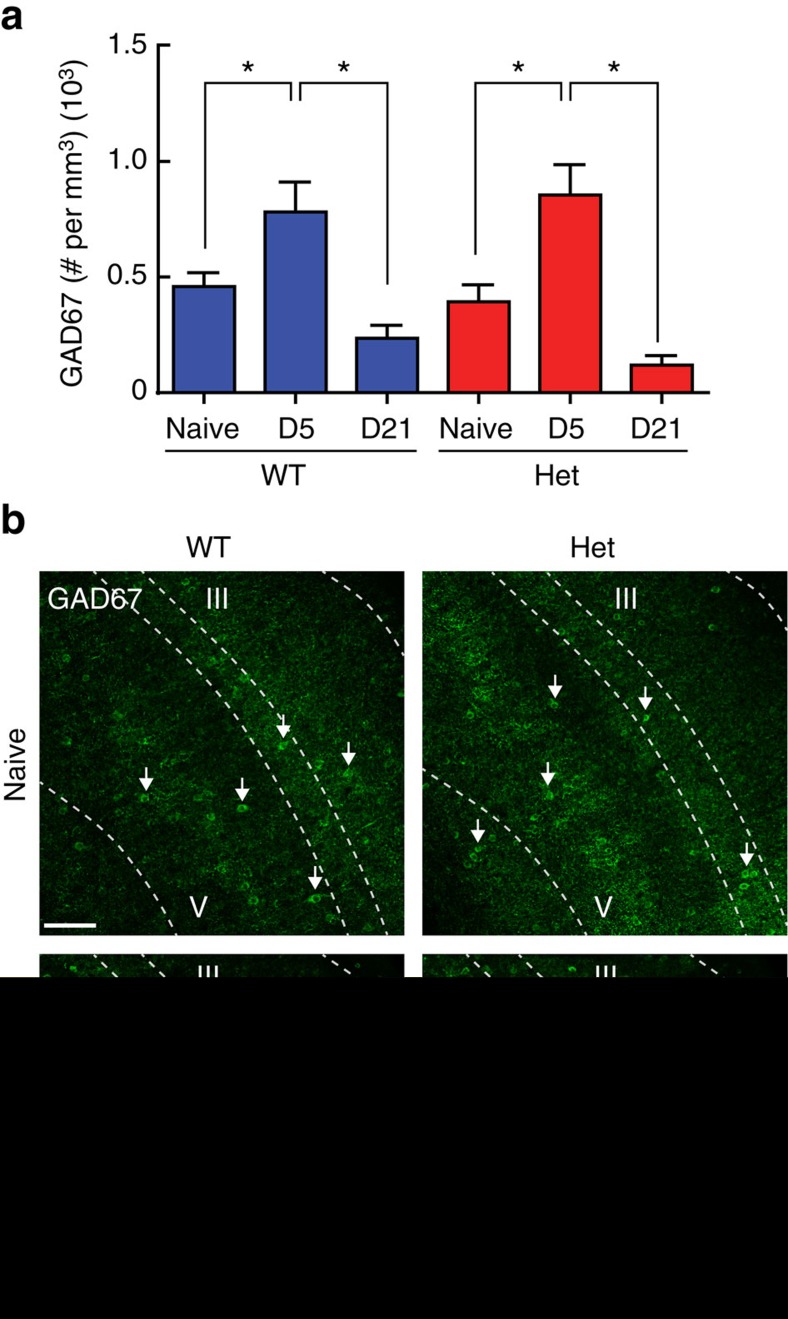
Maternal experience transiently enhances GAD67 expression level in the auditory cortex of wild-type and Mecp2het mice.(a) The density of high-intensity GAD67 cells was significantly increased in both SurWT (dark blue) and SurHet (red) at D5, and returned to naive levels at D21 (n=36–451 cells, 12–32 images, 4–8 mice; ANOVA: Tukey's post-hoc test, *P<0.05). Bar graphs represent mean±s.e.m. (b) Representative confocal images taken from the auditory cortex of a NaiveWT and NaiveHet (top row) and SurWT and SurHet at D5 (bottom row). Arrows point to high-intensity GAD67 cells. Scale bar, 100 μm, applies to all images. Dashed lines delineate cortical layers with layers III and V indicated.